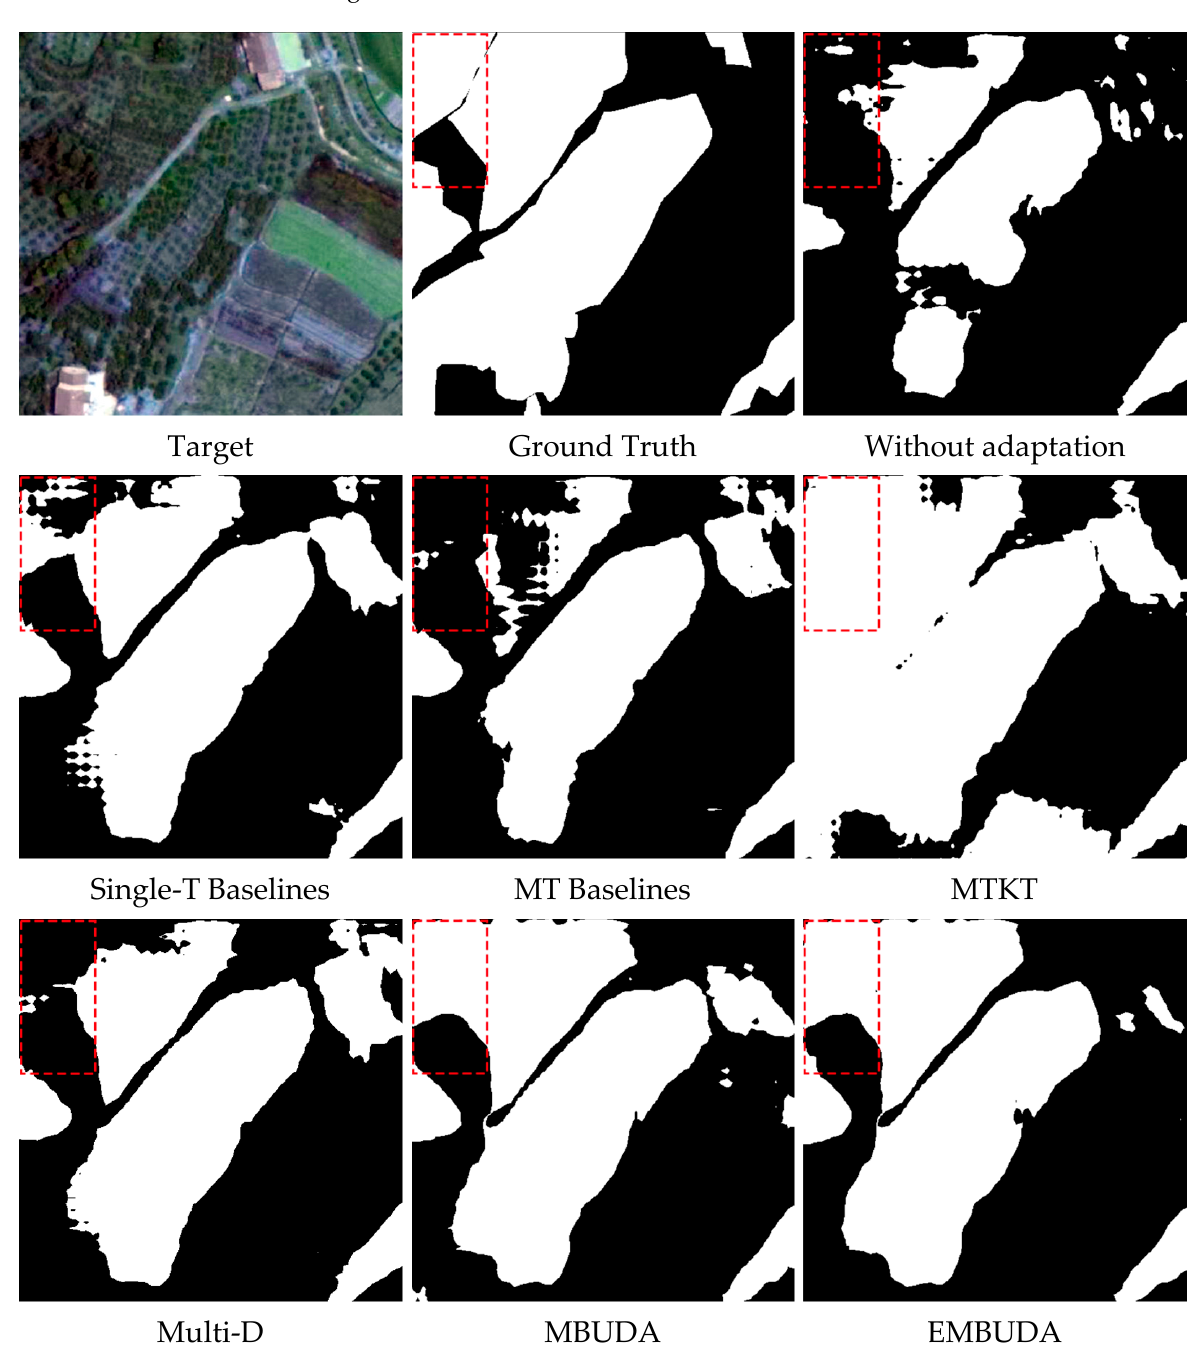
Figure A1. Outputs of orchard area segmentation in Dataset CY when adapting from Dataset ZG to Dataset CY and Dataset XT2.